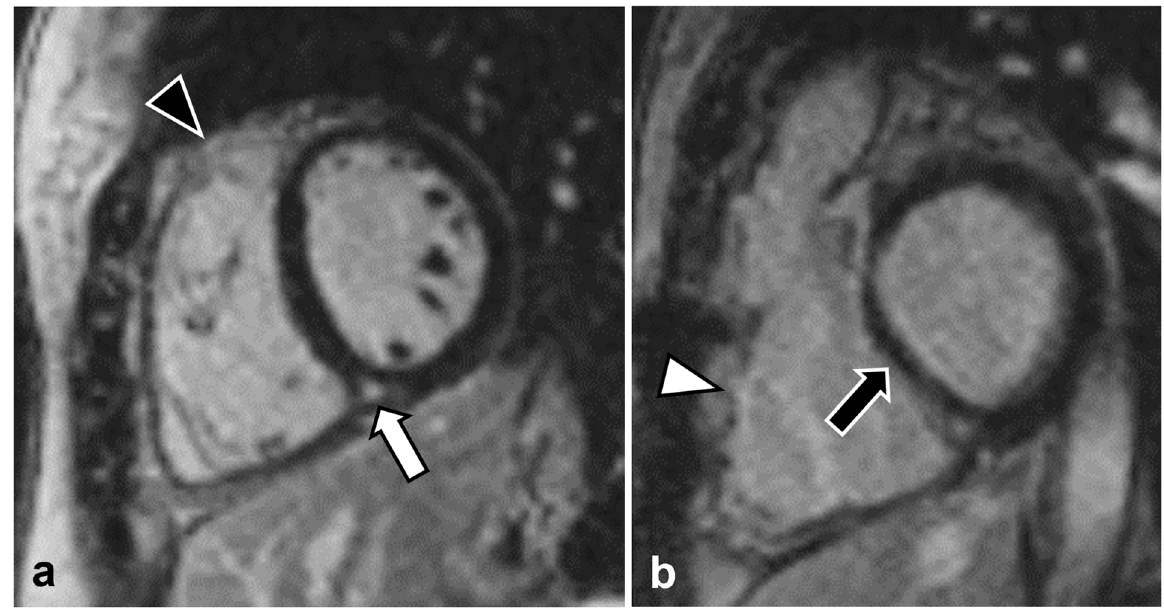
Fig. 1 Example of semiquantitative late gadolinium enhancement scoring in a 29-year-old female tetralogy of Fallot patient before pulmonary valve replacement, who was assigned a score of 2 for the free wall of the right ventricle outflow tract ( a , black arrowhead), 2 for the free wall of the right ventricle ( b , white arrowhead), 2 for the right ventricular septal wall ( b , black arrow), and 1 for the right ventricular insertion points ( a , white